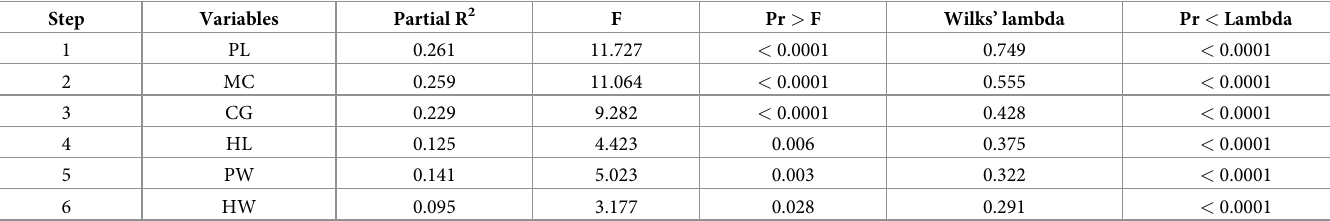
Table 3. Summary of stepwise selection of